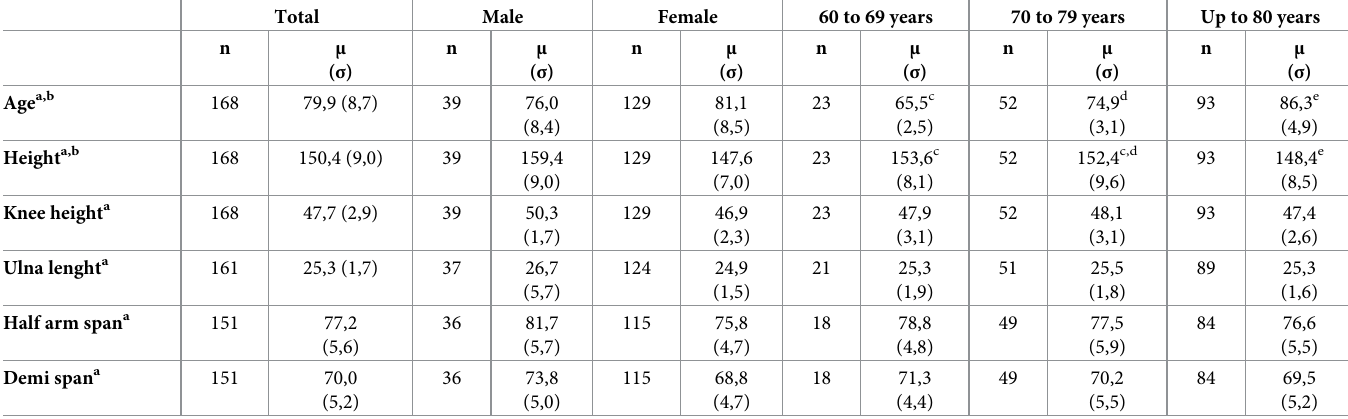
Table 2. Characterization of the elderly population living in nursing homes according gender and age, Brazil, 2014.